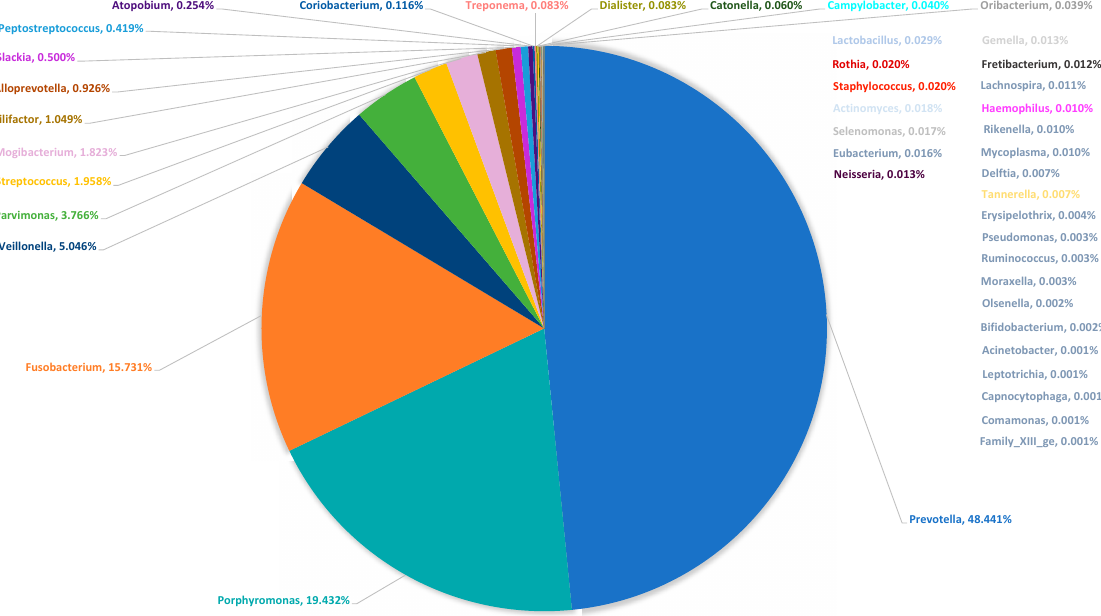
Figure 3. Median microbiome of the pus samples ( n = 48). The pie chart shows the median of the relative frequencies. The median was used because a normal distribution of the relative frequencies of the genera was not given.